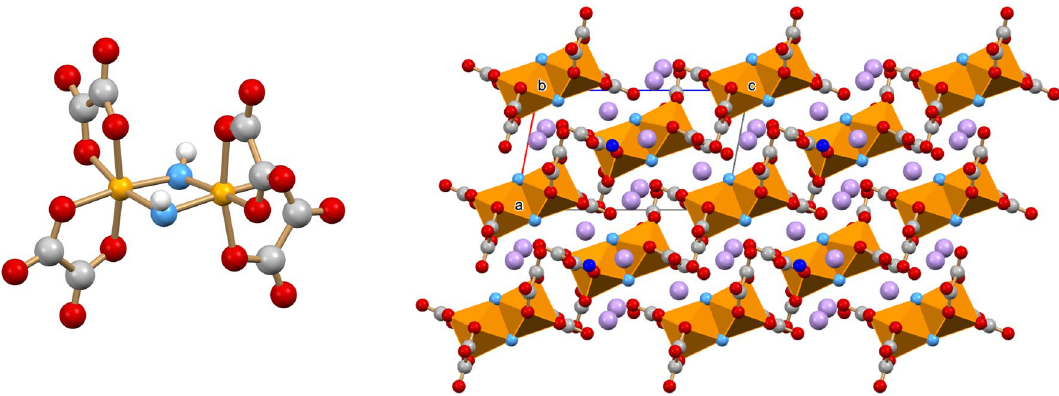
Figure 4. (Left) The [Ga 2 (ox) 4 (μ-OH) 2 ] 4− dimeric anion showing the bridging OH groups; (right) the packing arrangement viewed along the b -axis in crystalline K 4 [Ga 2 (ox) 4 (μ-OH) 2 ]·2H 2 O. K + in violet, O W in blue, O OH in cyano; H atoms omitted for clarity.